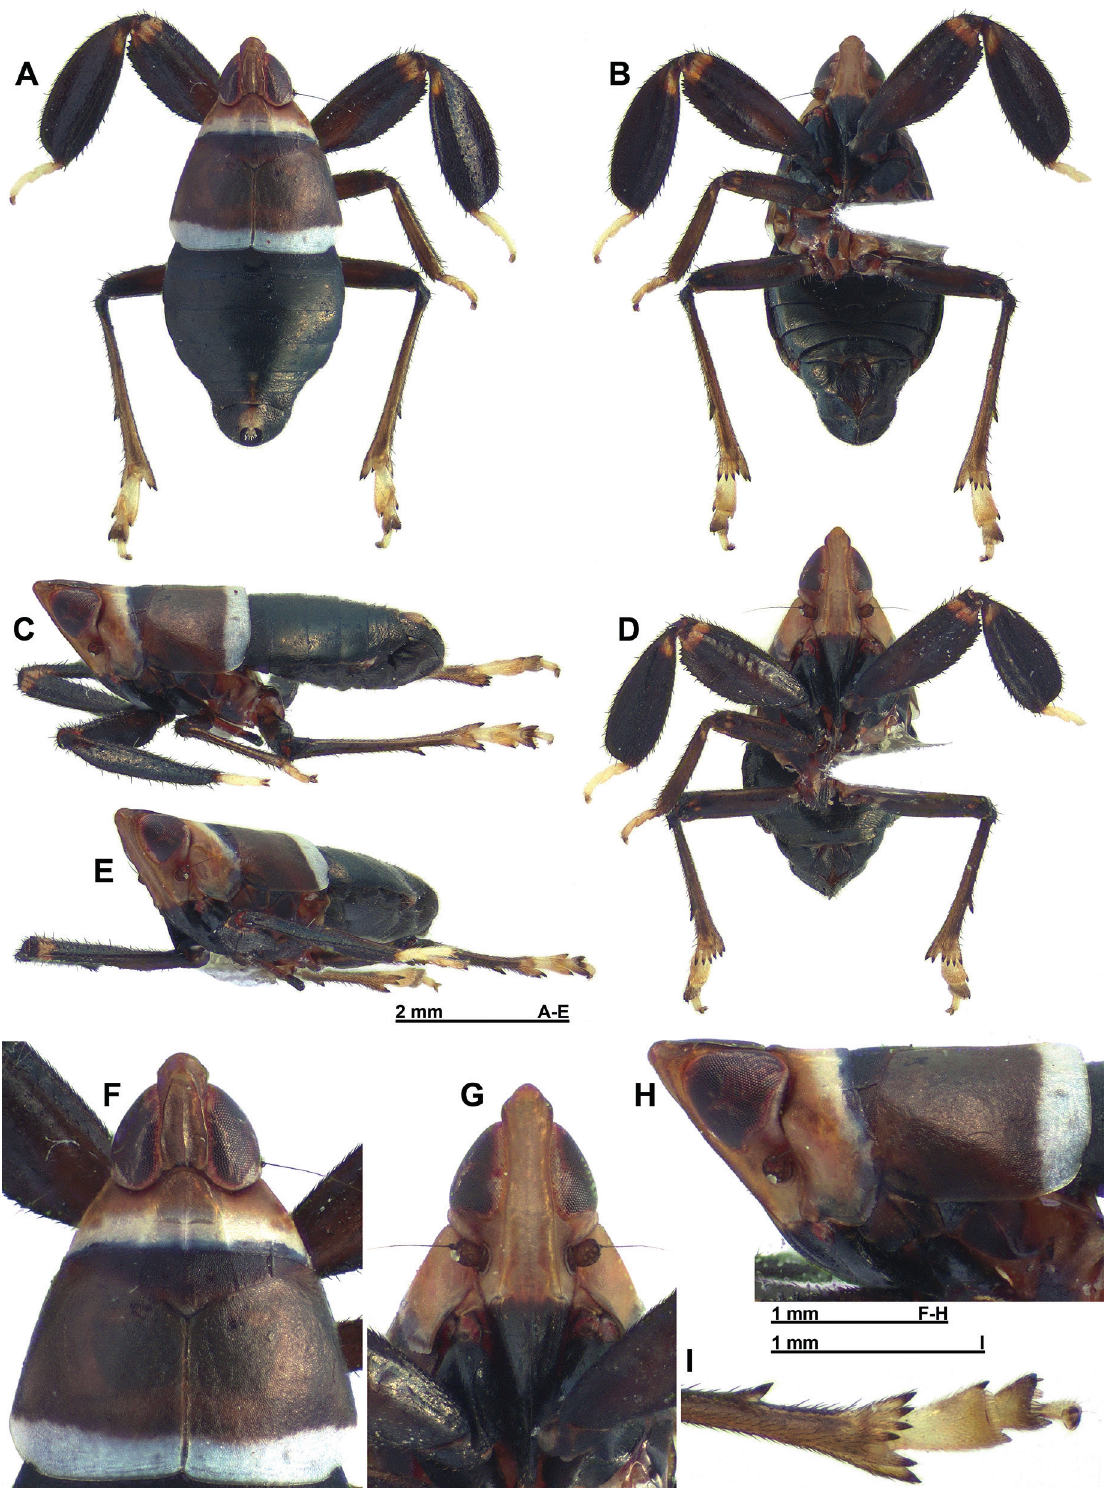
Fig. 8. Cleotyche ( Cleotyche ) francescoi sp. nov., ♀, paratype (QM). A . Habitus dorsal view. B . Habitus, ventral view. C . Habitus, lateral view. D . Habitus, perpendicular view of frons. E . Habitus, anterolateral view. F . Head and thorax, dorsal view. G . Frons, perpendicular view. H . Head and thorax, lateral view. I . Distal portion of posterior leg, ventral